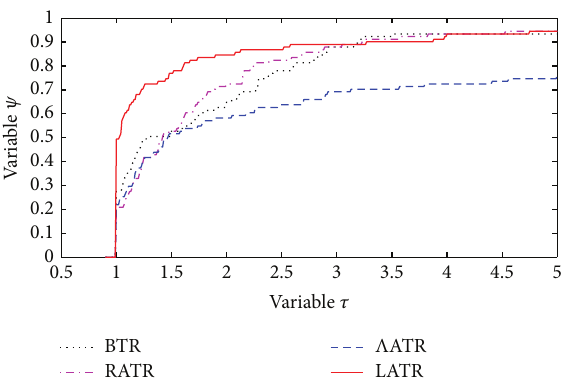
Figure 3: Performance profile comparing the sum of the number of function and gradient